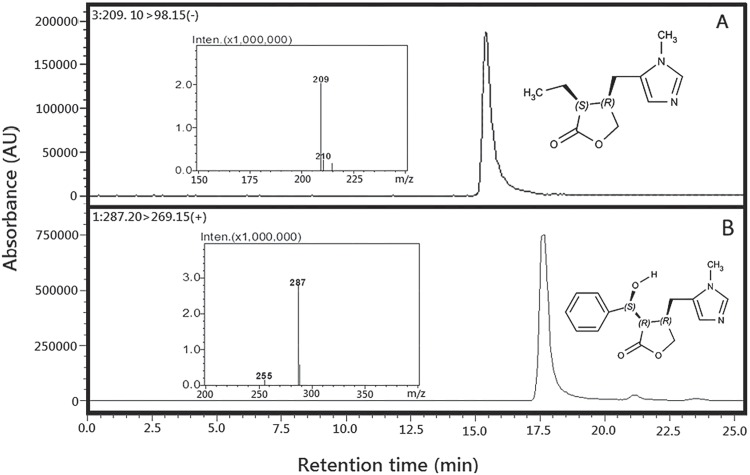
Chromatograms and mass spectra of alkaloid standards from Pilocarpus microphyllus analyzed by LC/MS.Pilocarpine, showing the retention time at 15.05 min and molecular weight for mass spectrometry, electron spray [M + H]+ at 209 Da. (B) Epiisopiloturine, showing the retention time at 17.05 min and molecular weight for mass spectrometry, electron spray [M + H] + at 287 Da.